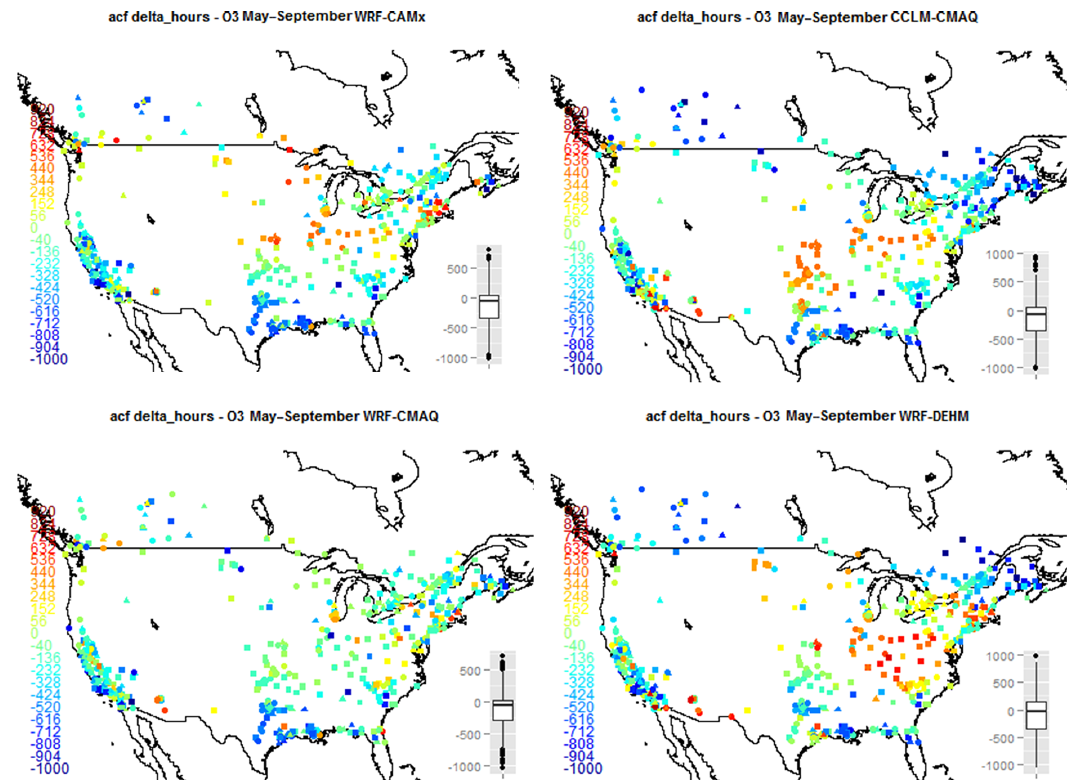
Figure 29. As in Fig. 28 but for North